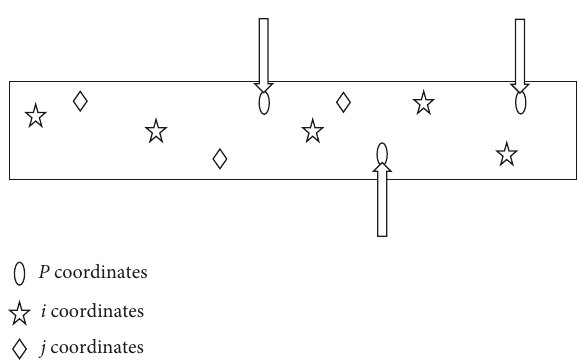
Figure 1: A structure with three types of coordinates P , i , and j